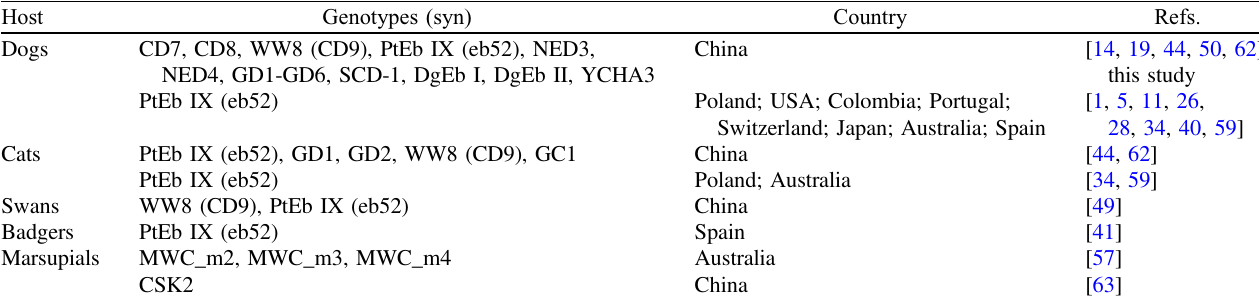
Table 3. Host ranges of E. bieneusi genotypes of group